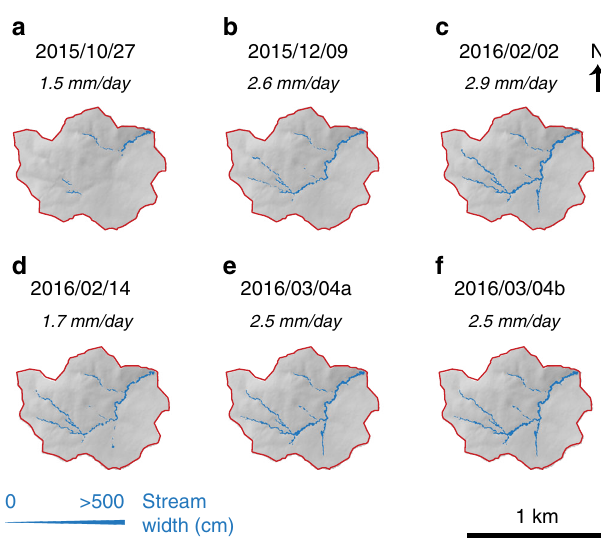
Fig. 2 Stony subcatchment repeat stream width maps with the basin- averaged runoff values in italic (dates in YYYY/MM/DD